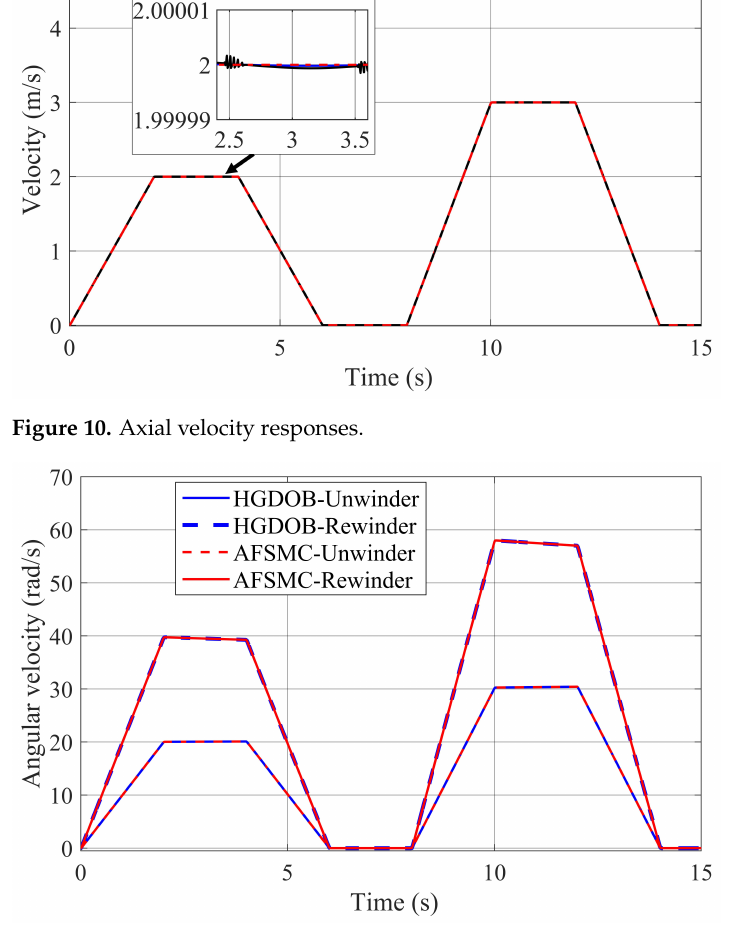
Figure 11. Angular velocity